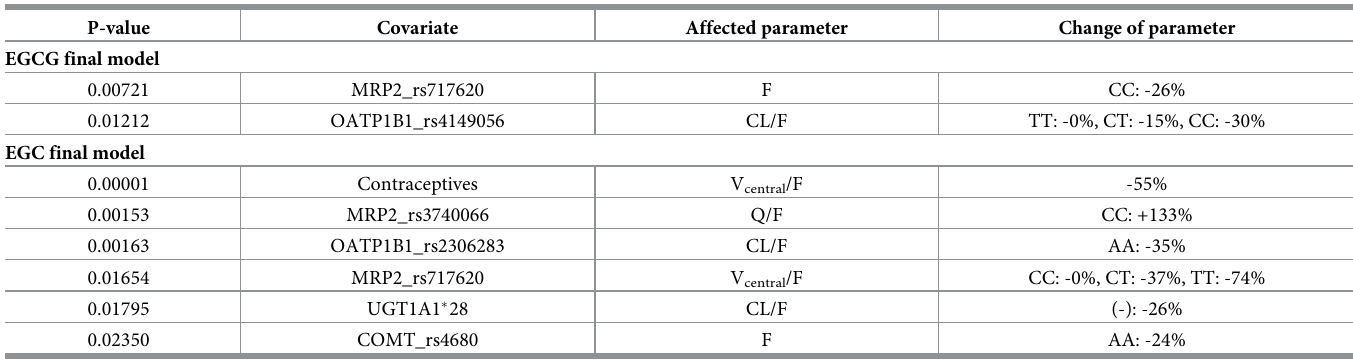
Table 5. Covariates included into the final